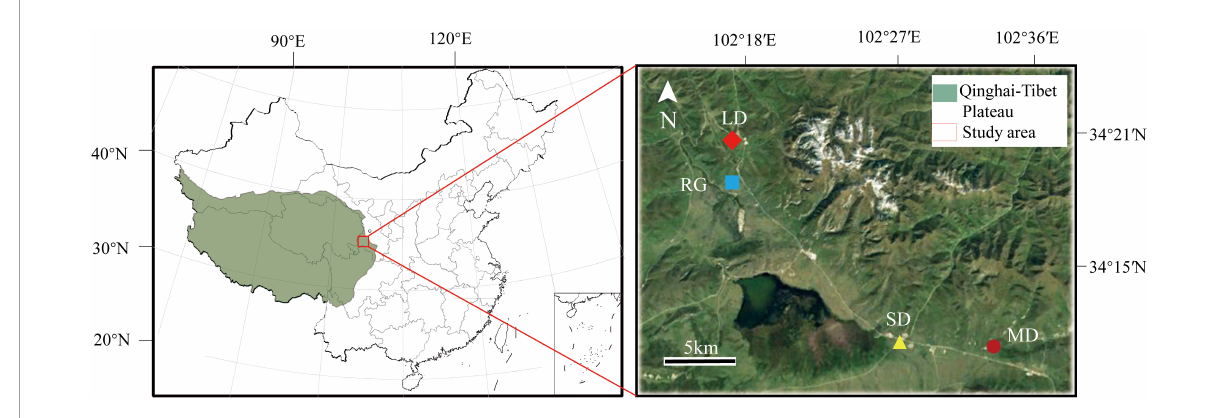
FIGURE1 Location of the sampling site. LD, lightly degraded grassland; MD, moderately degraded grassland; SD, severely degraded grassland; RG, reseeded grassland.